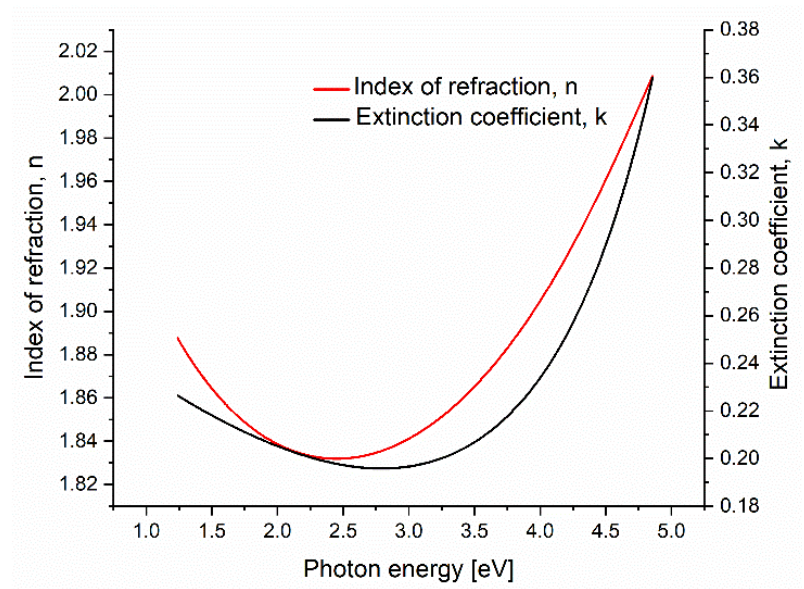
Figure 7. Estimated dispersion laws of RGO films on glass substrates by ellipsometry characterization. The curves represent the index of refraction (red curve) and the extinction coefficient (black curve).